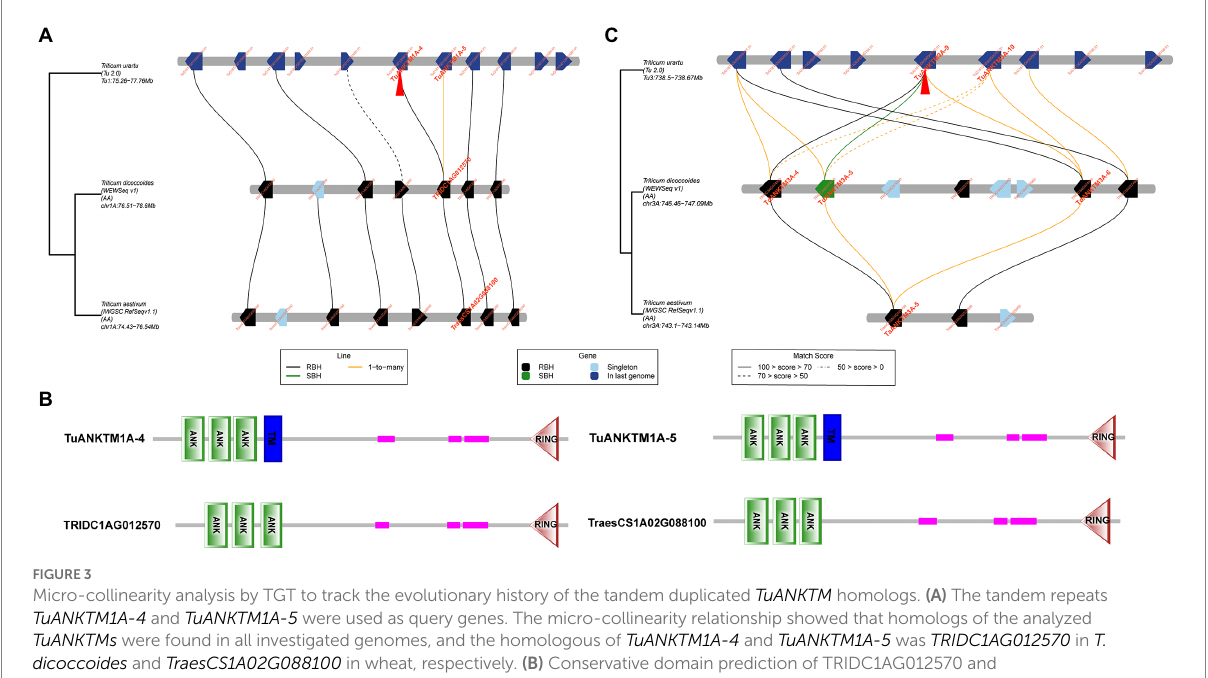
FIGURE 3 Micro-collinearity analysis by TGT to track the evolutionary history of the tandem duplicated TuANKTM homologs. (A) The tandem repeats TuANKTM1A-4 and TuANKTM1A-5 were used as query genes. The micro-collinearity relationship showed that homologs of the analyzed TuANKTMs were found in all investigated genomes, and the homologous of TuANKTM1A-4 and TuANKTM1A-5 was TRIDC1AG012570 in T. dicoccoides and TraesCS1A02G088100 in wheat, respectively. (B) Conservative domain prediction of TRIDC1AG012570 and TraesCS1A02G088100 proteins. The conserved domain prediction indicates that TRIDC1AG012570 and TraesCS1A02G088100 are ANK proteins with a RING finger domain. Abbreviations: ANK, ankyrin repeat; TM, transmembrane domain; RING, RING finger domain. (C) The tandem repeats TuANKTM3A-9 and TuANKTM3A-10 were used as query genes. TuANKTM3A-9 and TuANKTM3A-10 from T. urartu had a “1-to-many” pairwise homology with TdANKTM3A-4 , TdANKTM3A-5 and TdANKTM3A-6 in the A-subgenome of T. dicoccoides ; meanwhile the homologous of the above genes in the collinearity regions of common wheat was just TaANKTM3A-5 . Blackline, 1-to-1-mutual-best. Greenline, 1-to-its-best. Yellowline, 1-to-many. RBH, reciprocal best hits; SBH, single-side best